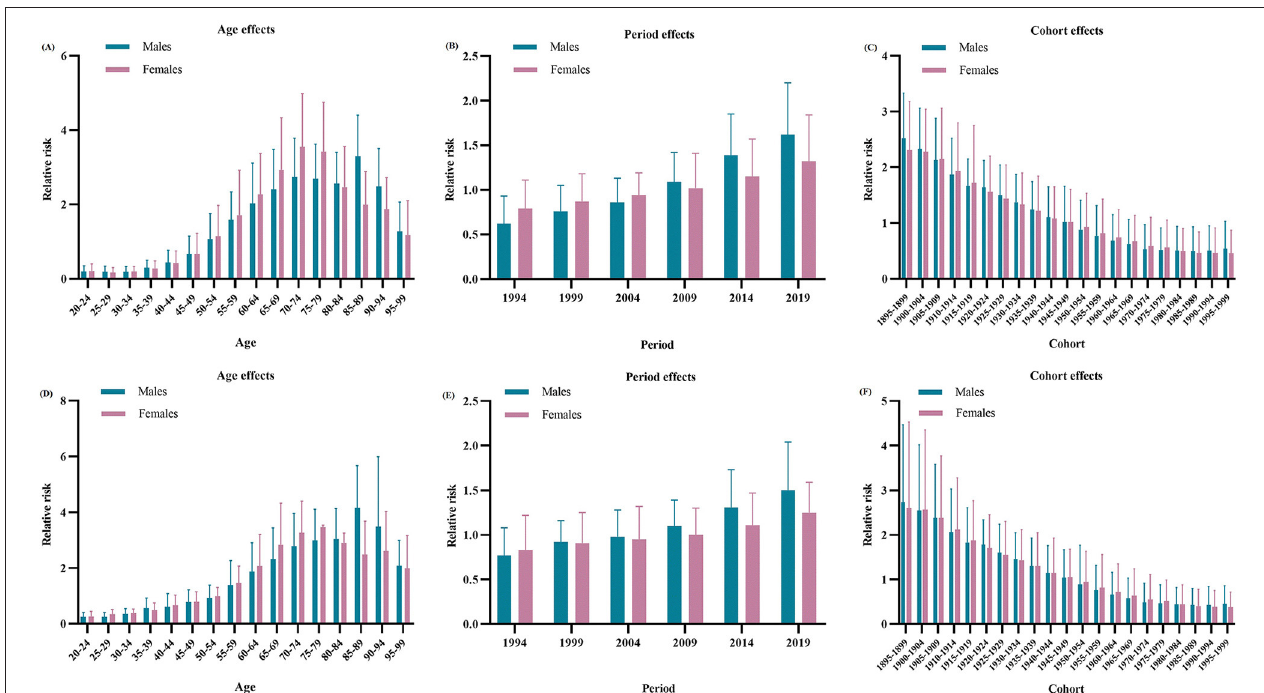
FIGURE 2 | Relative risks of incidence due to age (A) , period (B) , and cohort (C) effects, and relative risks of deaths due to age (D) , period (E) , and cohort (F) effects of multiple myeloma in China from 1990 to 2019.